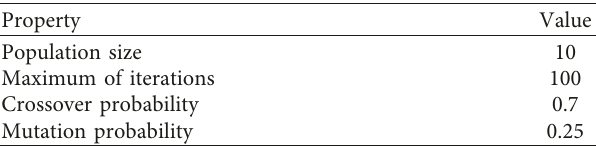
Table 3: CMDEA parameters.